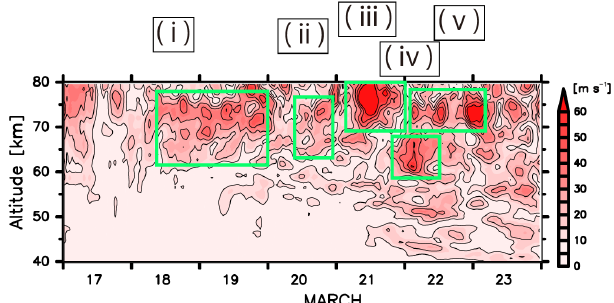
Figure 8. Time–altitude cross section of the envelope function of the zonal wind components of the large-scale gravity waves simu- lated by NICAM (contour interval 10ms − 1 ) . (i) to (v) denote the labels of the wave packet examined in Sect. 4.